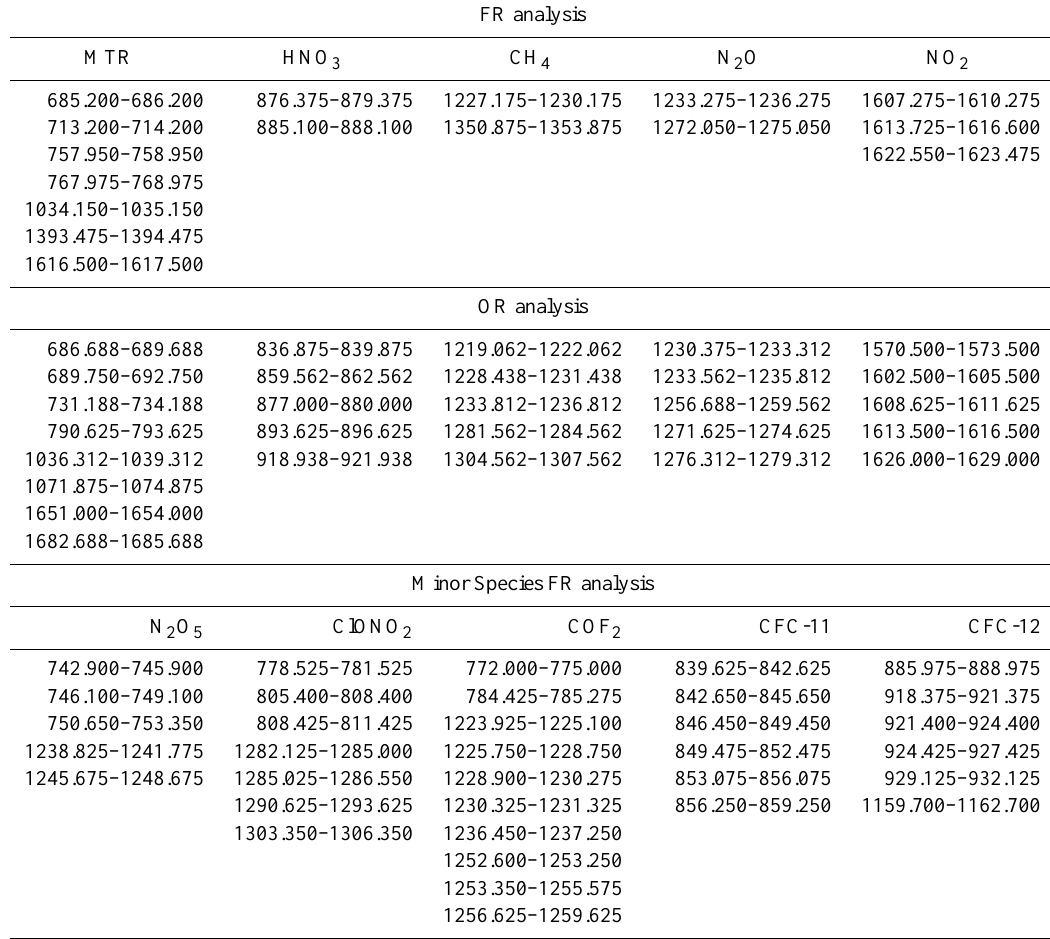
Table 2. List of the MWs (cm − 1 ) used for the retrievals of both FR and OR measurements. Note that specific spectral points within the MWs might be excluded from the retrieval to minimize the total